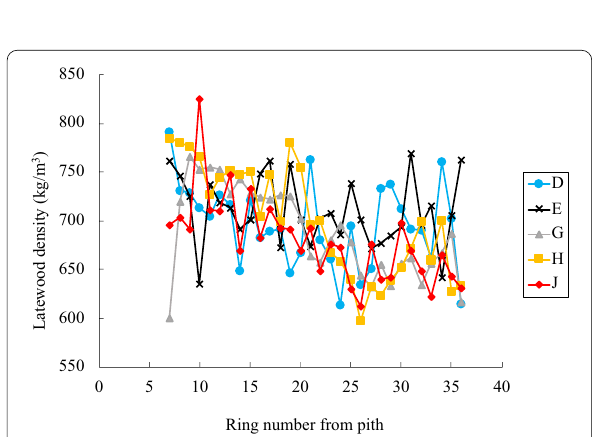
Fig. 7 Effects of initial tree density on latewood density. Each plot shows an average value in a ring number among sample trees of each tree density zoning symbol. Number of sample trees of each initial tree density zoning symbol range from five to nine. Initial tree density zoning symbols were the same, as shown in Table